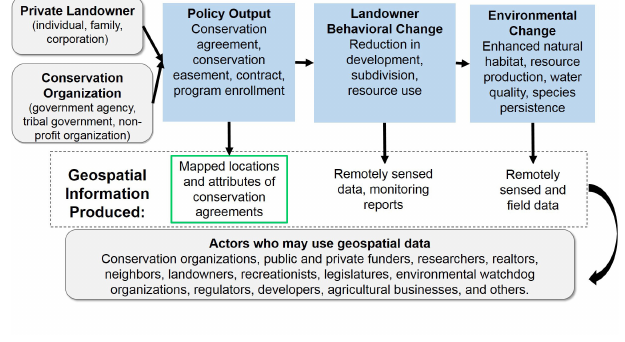
Fig. 1 . Conceptual framework for the role of spatial information in private-land conservation (modified from Rissman and Sayre 2012 with the addition of geospatial information). The underlying theory of change is that conservation agreements (policy outputs) change landowner behavior, which changes environmental conditions (environmental outcome), compared to what would have occurred without the conservation agreement. The green box surrounds the focus of this paper’s four case studies: maps and attributes of conservation